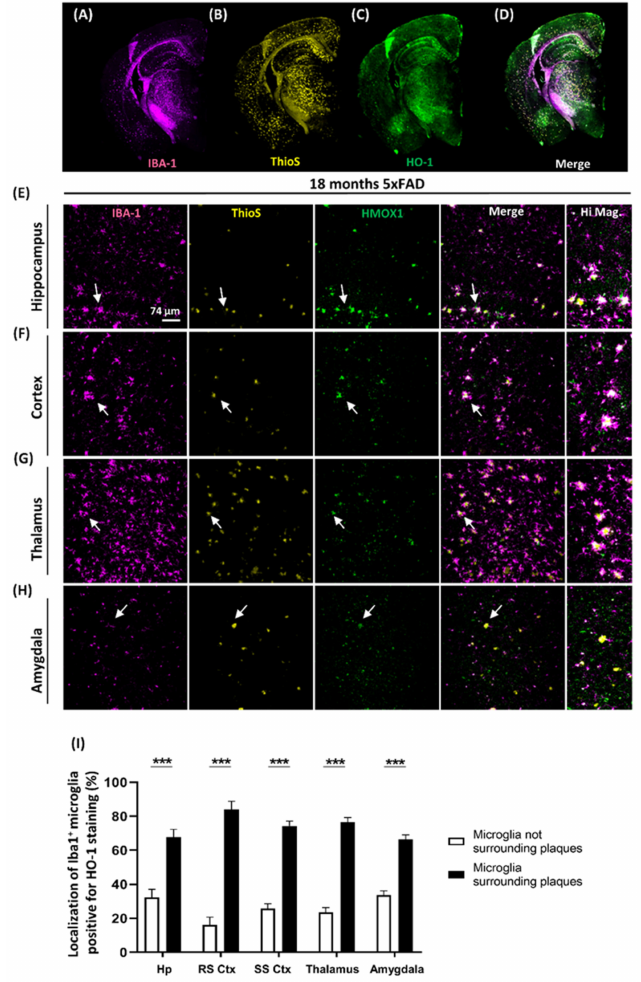
Figure 5. Microglial HO-1 overexpression in 5xFAD mice is preferentially localized surrounding β -amyloid plaques. 10x representative whole brain images (18-month-old 5xFAD mice) of Iba1 + microglia (magenta) ( A ), Thio-S (yellow) ( B ), HO-1 (green) ( C ) and the merge channel (white when colocalized) ( D ). 40x representative immunofluorescence images of Iba1 + microglia, Thio-S + plaques and HO-1 in 18 months 5xFAD mice in di ff erent brain regions: hippocampus ( E ), cortex ( F ), thalamus ( G )andamygdala( H ).( I )MicroglialHO-1expressionoccursmainly(~75–80%)inmicrogliasurrounding plaques in all the di ff erent brain regions studied. ( N = 6). Significant di ff erences were considered when: *** p < 0.001 compared to age-matched WT mice. Data represent mean ±